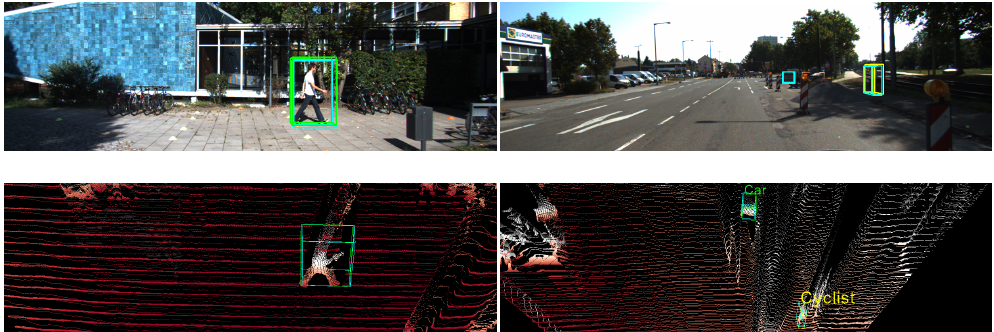
Figure 9. Detection of a pedestrian and a cyclist. Top row images are frontal-view, and bottom row images are bird’s-eye-view point cloud maps. Ground truth boxes are in green, and predicted results are in yellow. Our proposed framework is able to create accurate 3D boxes for a pedestrian and a cyclist, and our DDA module can produce reasonable shapes for point